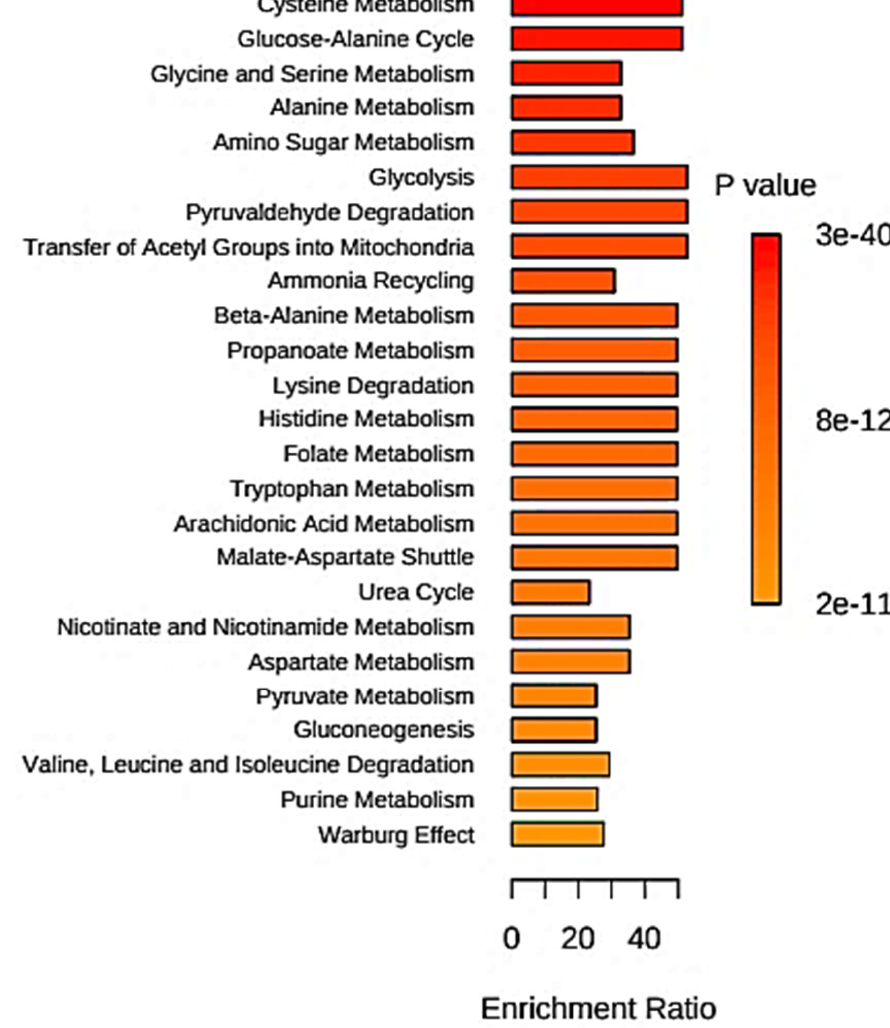
Figure 8. Overall summary plot for Quantitative Enrichment Analysis (QEA) performed on human host-contributory salivary metabolites, showing enrichment ratios and corresponding p values for the top 25 metabolic pathways which are indicated as being the most highly dysregulated for humans affected by an acute sore throat condition. QEA was performed using the globaltest package option [88], which employed a generalized linear model to estimate Q statistics for metabolite sets; such Q statistics represent correlations between metabolite concentration profiles (predictor X variables) and the clinical outcome (Y variable). The Q statistic provided for a metabolite set represents the mean value of the Q statistics for each metabolite within that set. The small molecule pathway database (SMPDB) metabolic pathway-associated metabolite sets consisted of 99 entries.